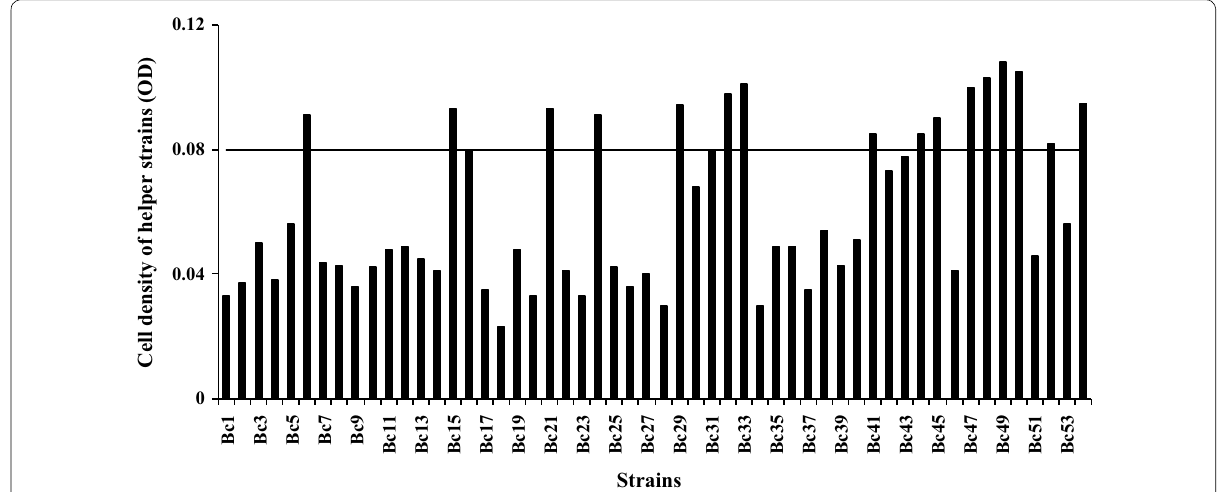
Fig. 3 Determination of cell density of helper strains in the first screening step